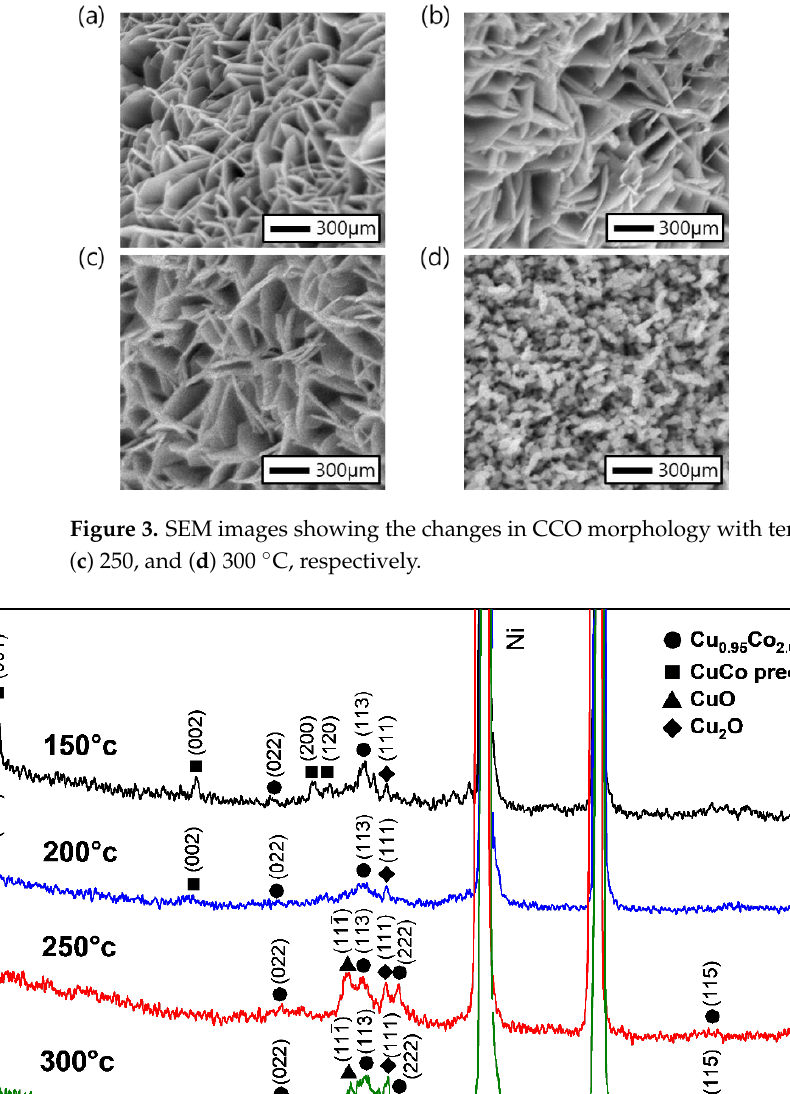
Figure 2. ( a , b ) SEM images and ( c ) XRD pattern of electrodeposited CCOH. ( d ) Proposed structure of Cu 1-x Co x (OH) 2 (NO 3 ).